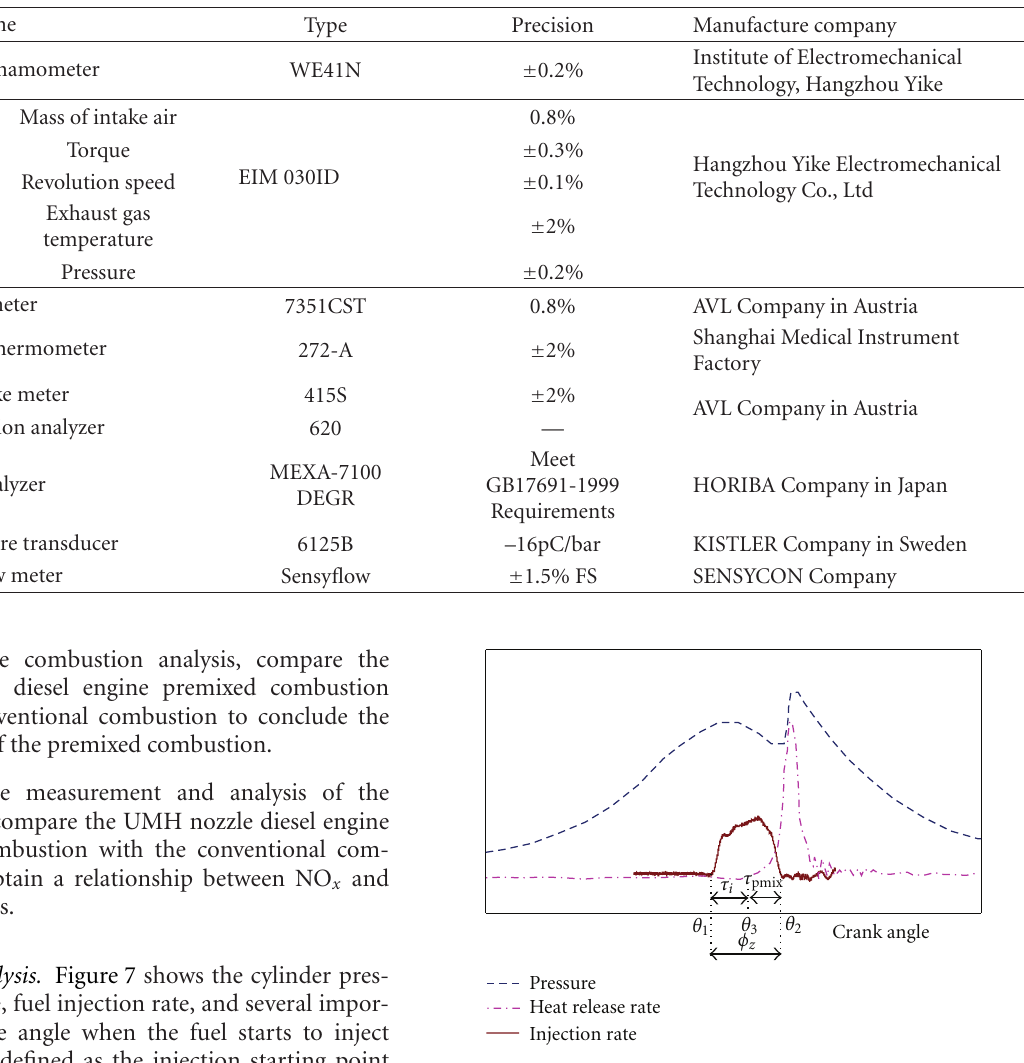
Figure 7: Definition of combustion parameters.